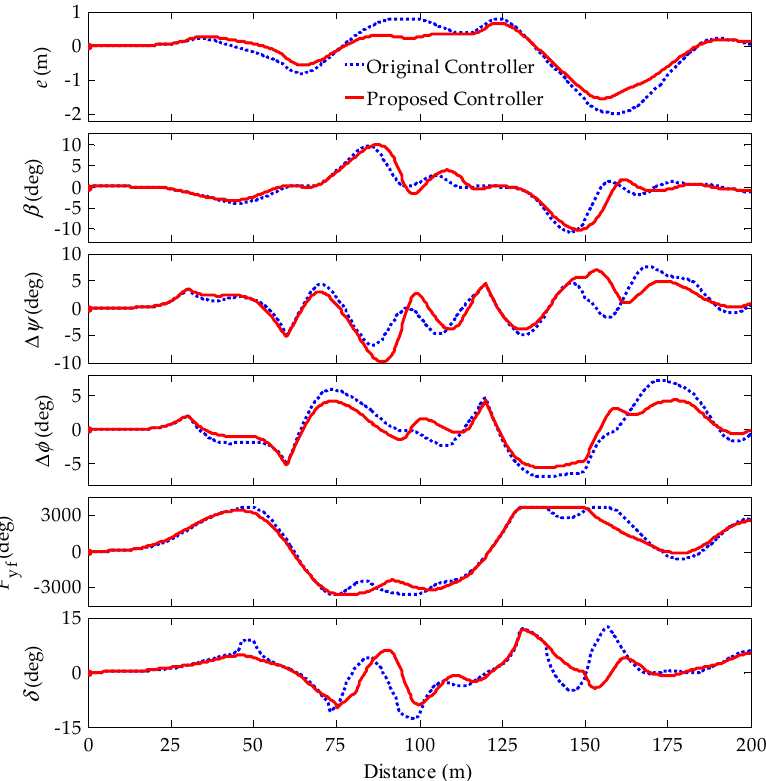
Figure 12. Simulation results over 0–200 m. The lateral deviation e , sideslip beta β , heading deviation Δ ψ , course-direction deviation Δ φ , front-tire lateral force F yf and steering angle δ of proposed controller are compared with that of original controller over 0–200 m.